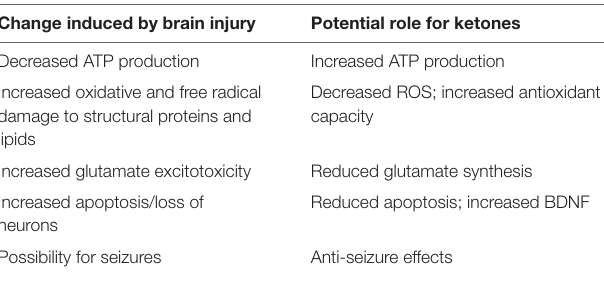
TABLE 2 | Characteristics of brain injury vs. effects of